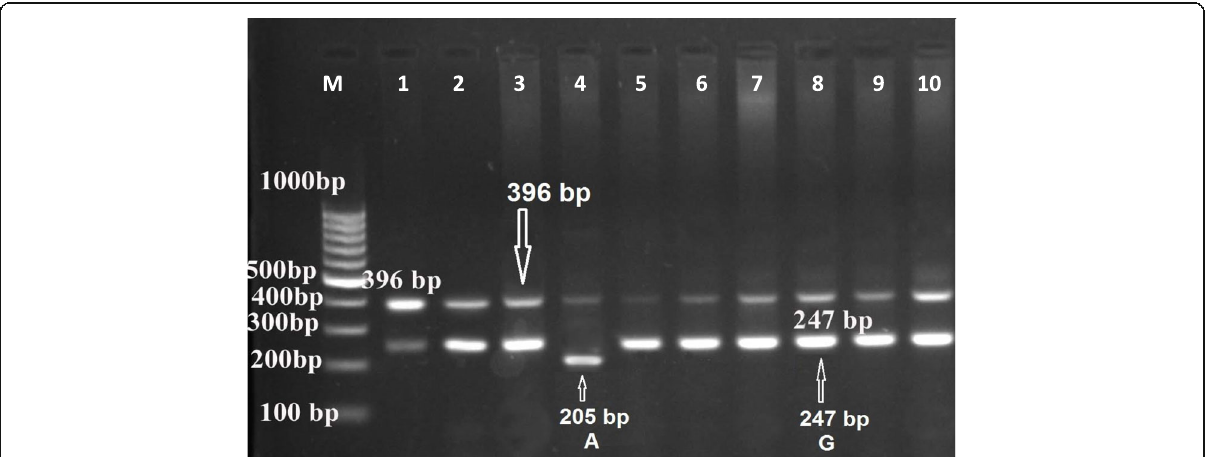
Fig. 1 Electrophoresis of agarose gel (2%) of polymerase chain reaction (PCR) product of tetra-primer amplification refractory mutation system- PCR for G1 locus of GDF9 gene. The Lanes of 1 to 10: Amplification of wild type or heterozygous in a mother sheep genomic DNA. Sizes of common outer